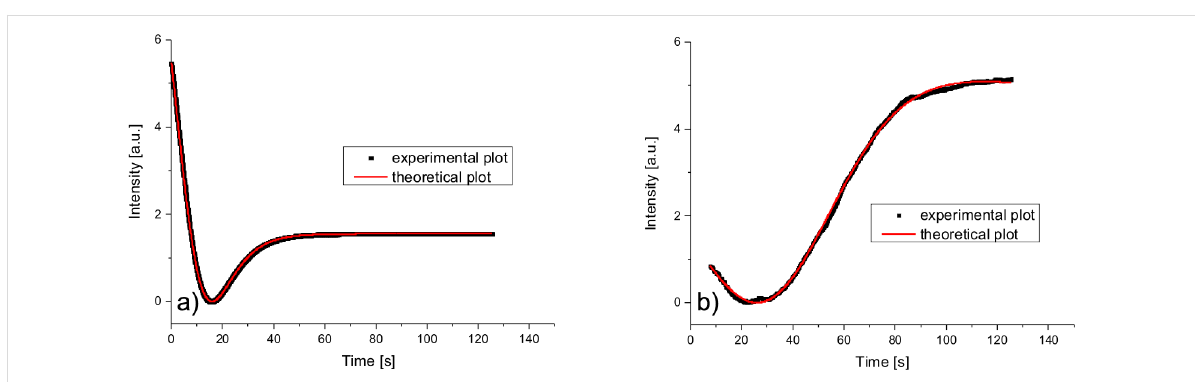
Figure 6: Experimental results and theoretical curves for a magnetic field of 0.1050 T applied to the mixture of 5CB and CoFe 2 O 4 cell. a) The field was applied, b) the field was switched off.